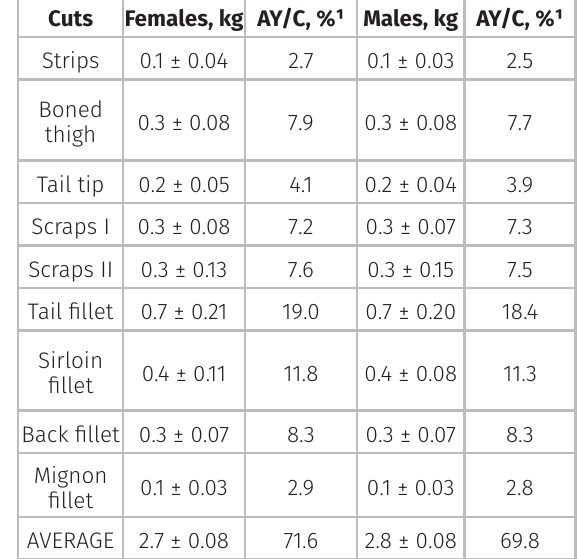
Table I. Analysis of the yield of commercial cuts in relation to animals’ carcass (%), and average weight of the cuts of slaughtered caiman, separated by sex (females and